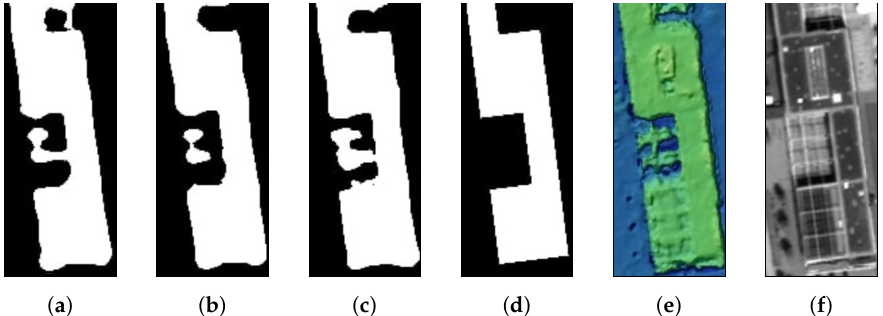
Figure 9. The detailed comparison between different fusion strategies for binary building mask generation: ( a ) EarlyConc-PAN&MS&DSM-mrFCN4s, ( b ) LateConc-PAN&MS&DSM-mrFCN4s, ( c ) Hybrid-PS-FCN4sand ( d ) ground truth. ( e , f ) depict color-shaded DSM and PAN example of selected building,